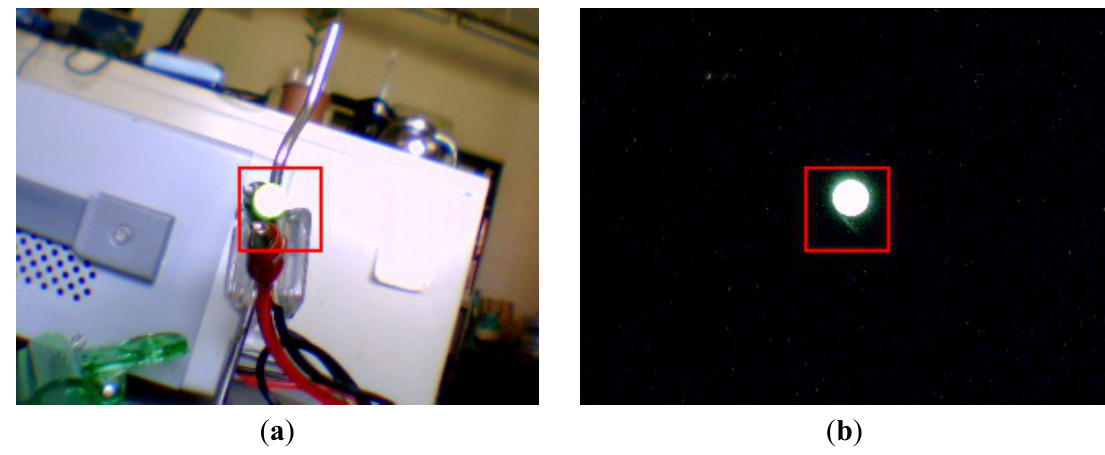
Figure 1. The test case of LED system: ( a ) the LED setup. ( b ) the luminescent state of LED